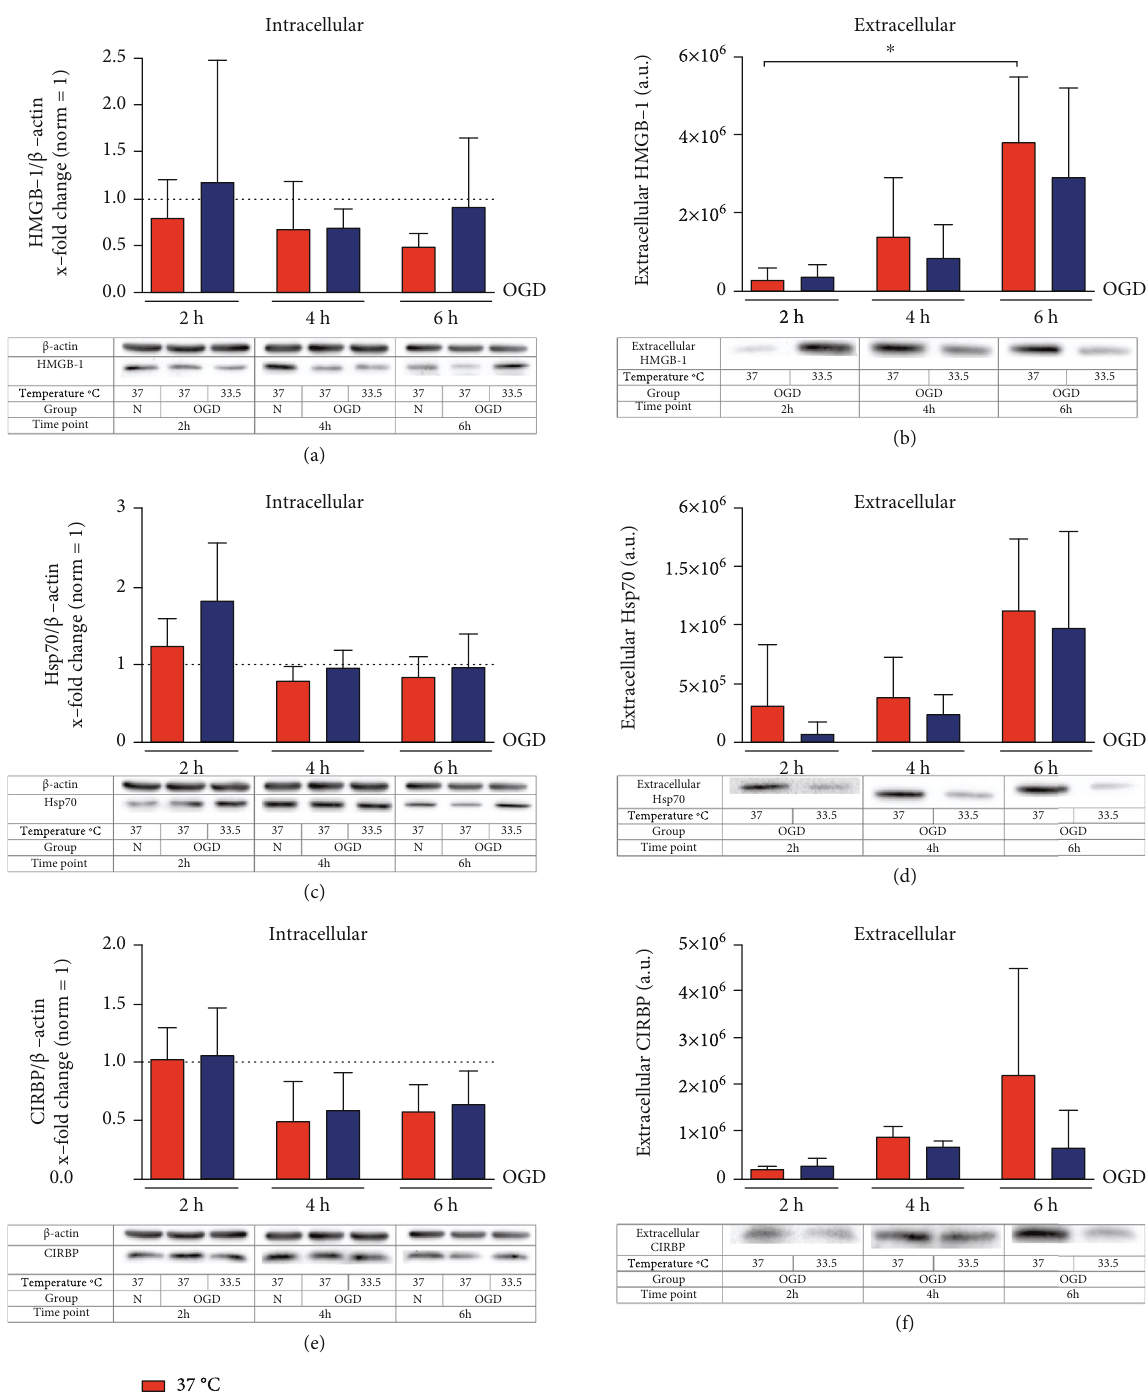
Figure 4: Western blot analysis of intracellular expression and extracellular release of the following DAMPs: (a, b) HMGB-1, (c, d) Hsp70, and (e, f) CIRBP after exposure to 2, 4, and 6 hours OGD at 37 ° C and 33.5 ° C, respectively. Data from at least 3 independent experiments are shown as mean ± SD . Statistical analysis was performed using one-way ANOVA with Tukey posttest; # p < 0 : 05 as compared to 37 ° C normoxia control group and ∗ p < 0 : 05 comparison between the two experimental groups were considered signi fi